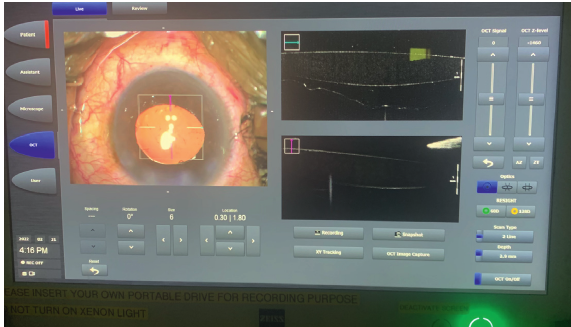
Figure 1: Display of an image of the intraoperative optical co- herence tomography (iOCT) integrated into the microscope during the cataract